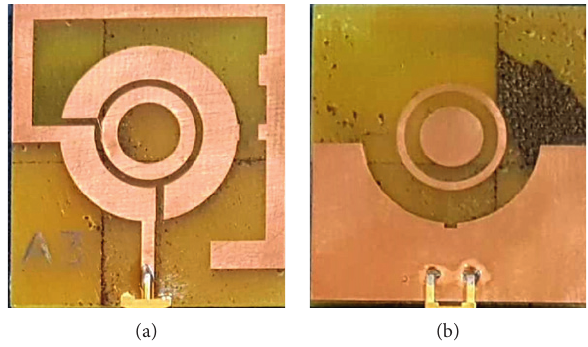
Figure 5: Manufactured antenna design.